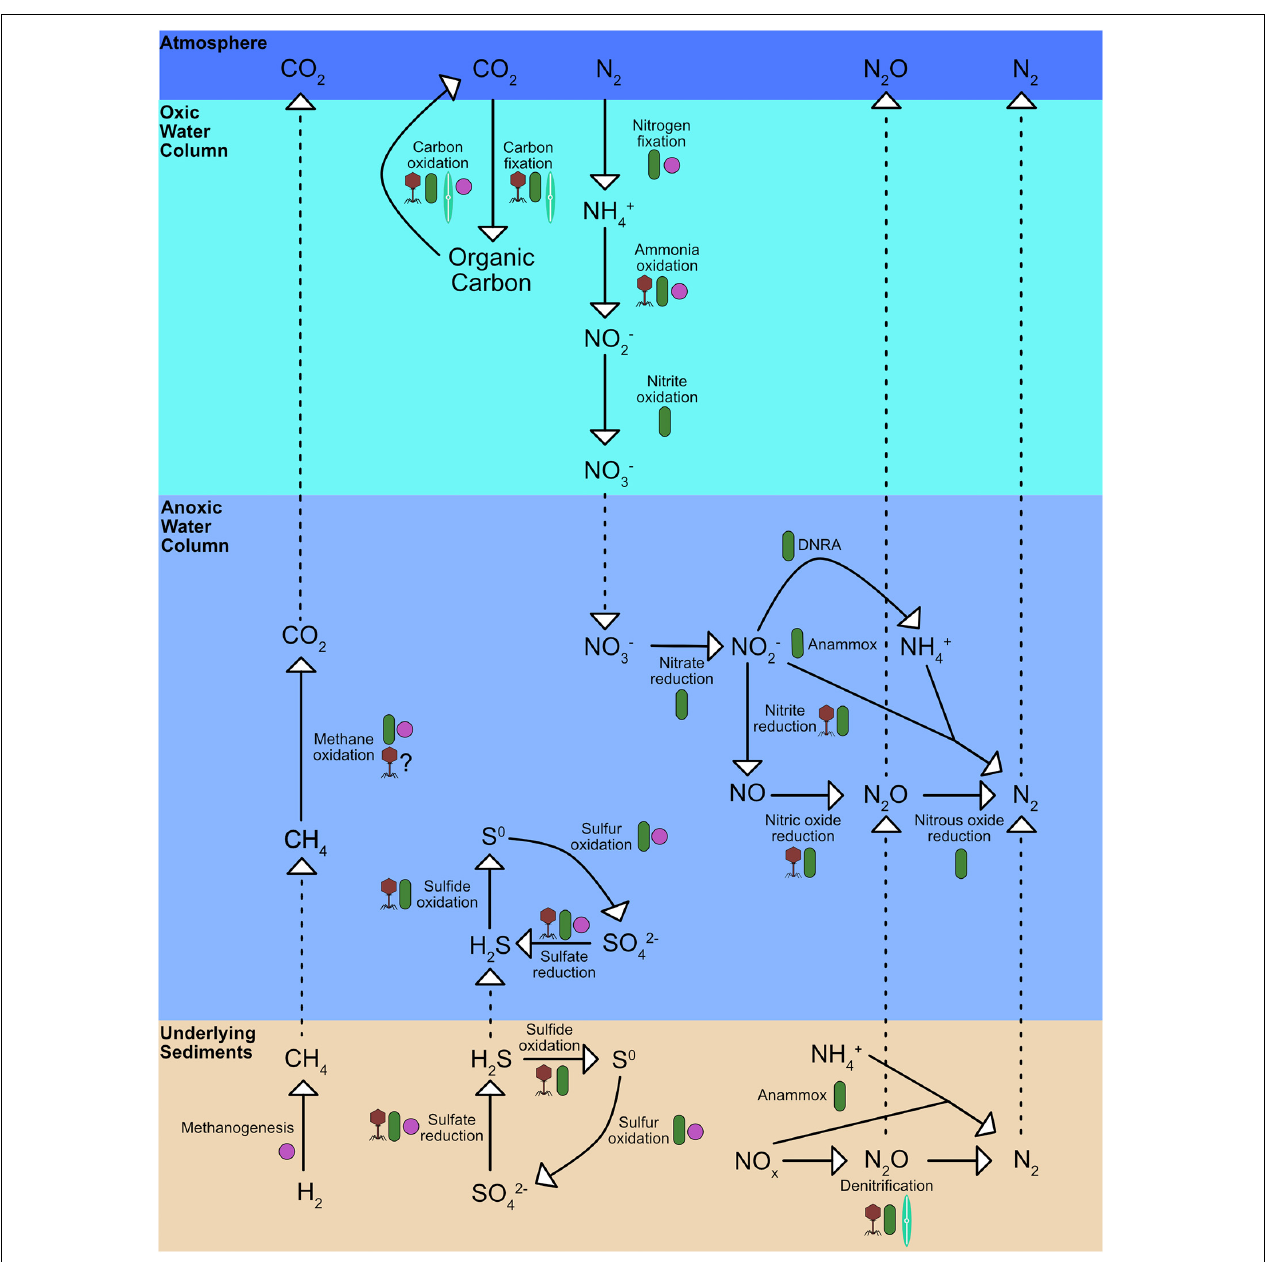
FIGURE 2 | Simplified schematic of carbon, nitrogen, sulfur cycles in oxygen minimum zones, underlying sediments and overlying oxic waters. Purple cocci shapes represent processes that archaea perform, green rods represent bacteria, teal pennate diatoms represent microeukaryotes, and maroon phage particles represent processes viruses potential augment. Full details in